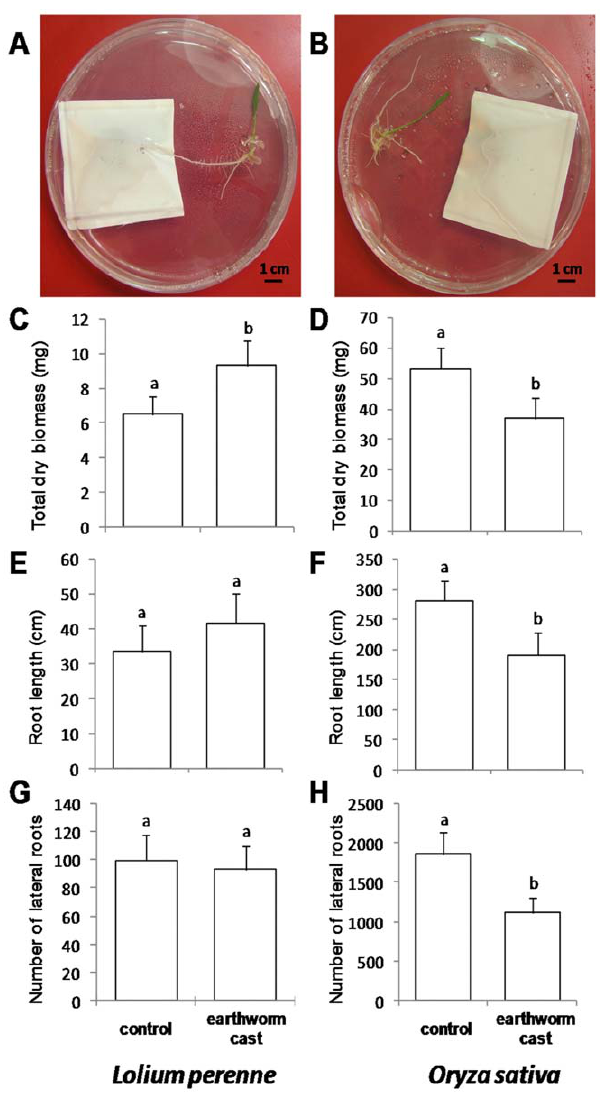
Figure 1. Effect of earthworm casts on plant growth in invitro experiments. Experimental in vitro device with Oryza sativa in presence of (A) casts of Aporrectodea caliginosa or (B) equivalent weight of control soil enclosed into a nylon membrane. Effect of Aporrectodea caliginosa ’s casts on total biomass production of (C) Lolium perenne and (D) Oryza sativa . Effect of Aporrectodea caliginosa ’s casts on root length of (E) Lolium perenne and (F) Oryza sativa . Effect of Aporrectodea caliginosa ’s casts on the number of lateral roots of (G) Lolium perenne and (H) Oryza sativa . Means 6 s.e., n=10 per treatment, different letters indicates a significant difference, Tukey HSD, P ,